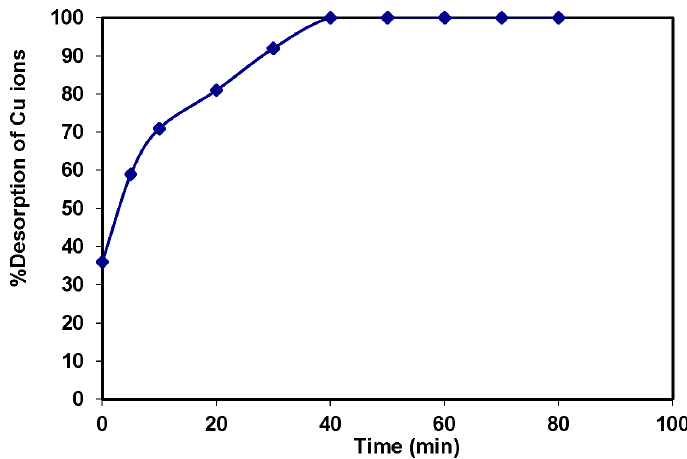
Figure 14. Desorption kinetics of copper ions from MANSG using 0.02 N EDTA.